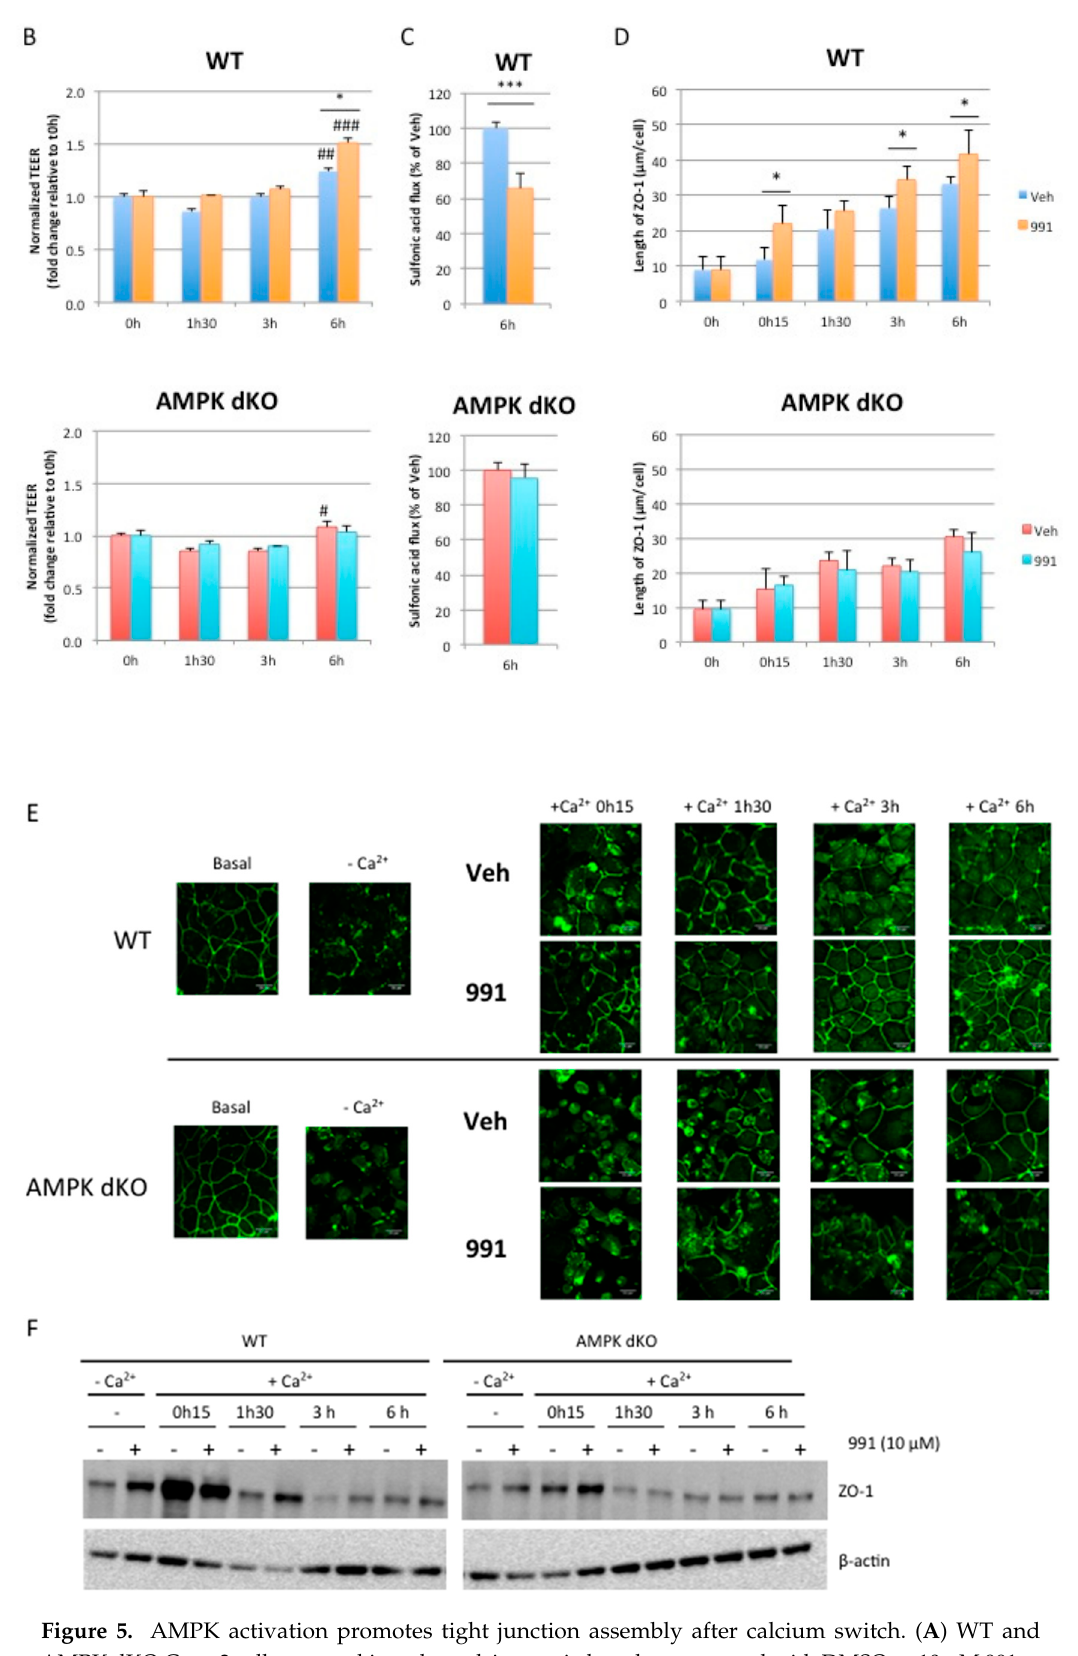
Figure 5. AMPK activation promotes tight junction assembly after calcium switch. ( A ) WT and AMPK dKO Caco-2 cells were subjected to calcium switch and were treated with DMSO or 10 µM 991 at indicated time points. Cell lysates were analyzed for Thr-172 phosphorylation and total AMPK